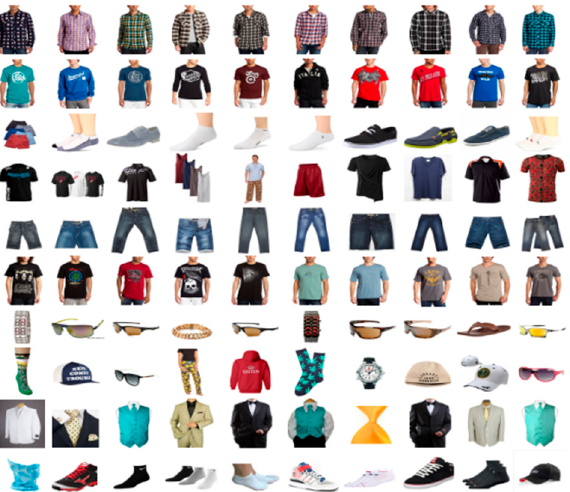
Figure 7. Demonstration of 10 randomly selected visual spaces of men’s clothing. Each row shows one visual space.